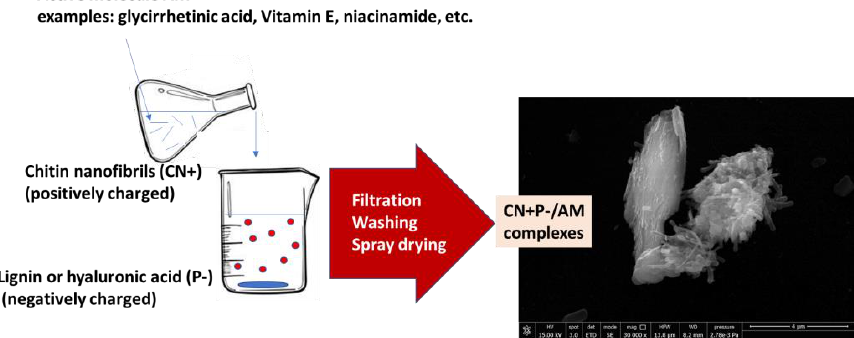
Figure 8. The ionic gelation method to produce the complex between hyaluronic acid and chitin nanofibrils.